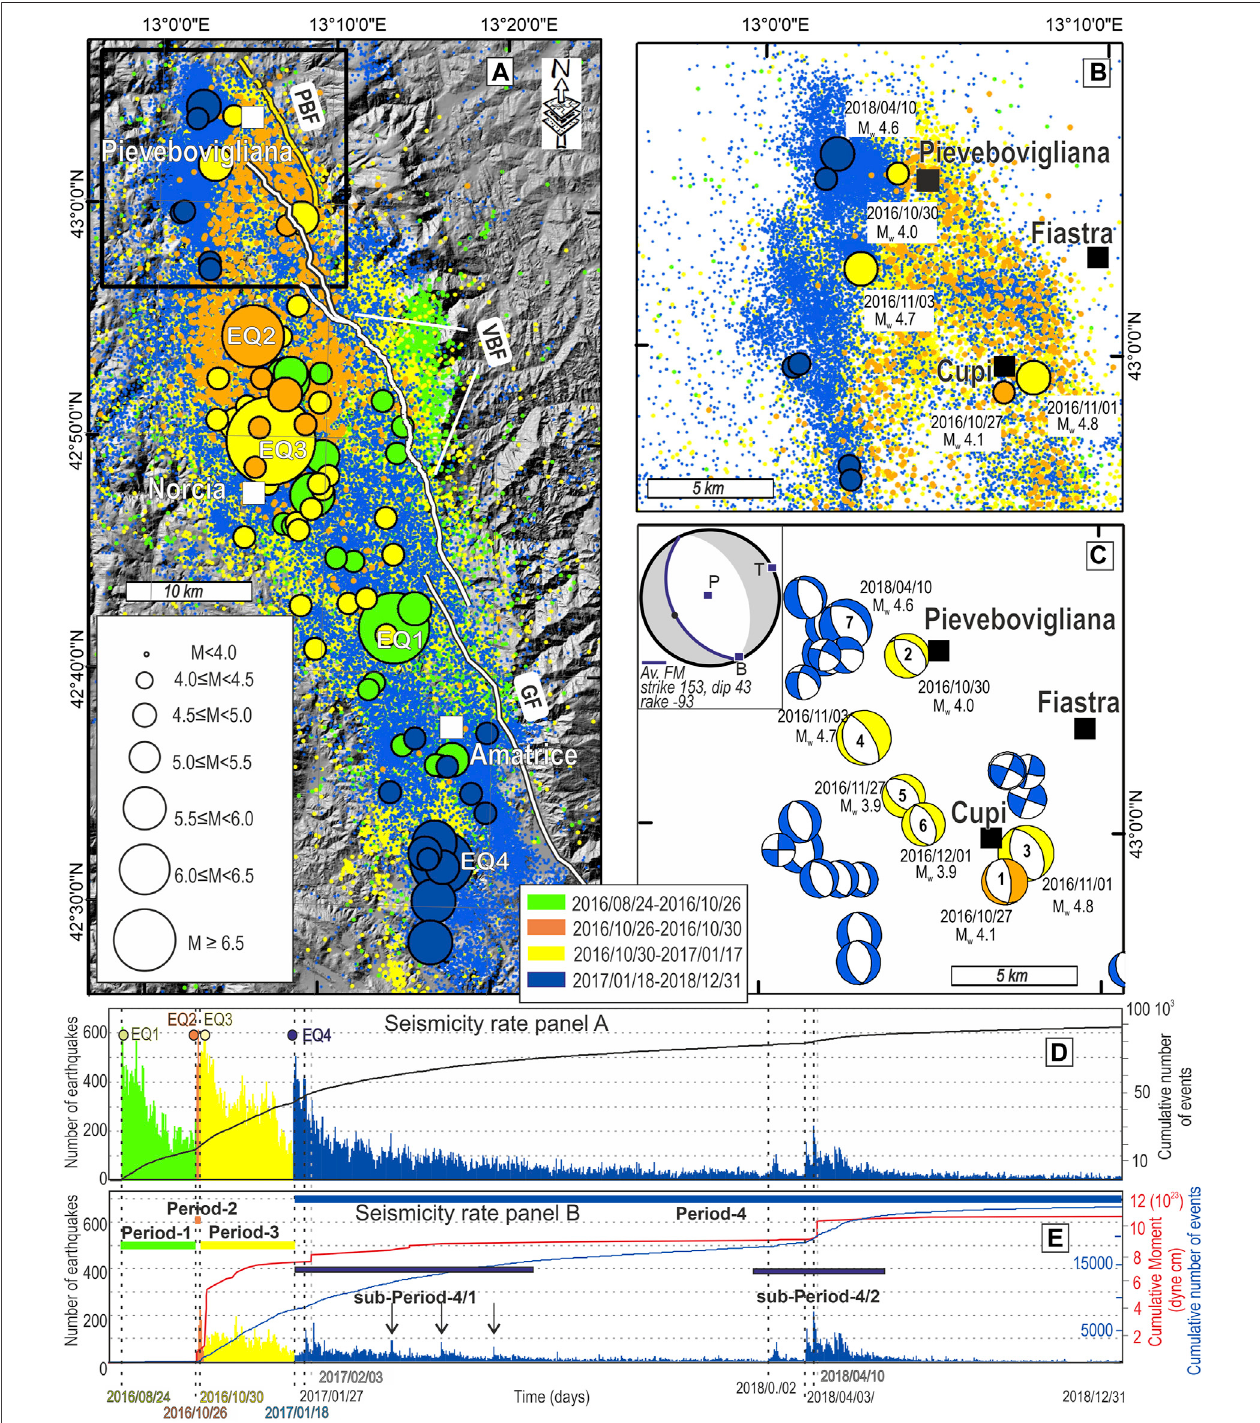
FIGURE 2 | Spatio-temporal evolution of seismicity from August 24, 2016 to December 31, 2018. (A) Epicentral distribution of earthquakes occurred during the Norcia seismic sequence with M L ≥ 1.0 and depth < 20 km reported by the Italian seismological Instrumental and Parametric database (ISIDe Working group, 2007). The colors of epicentres indicate four different time intervals following the main seismic events: August 24, 2016, M w (cid:1) 6.0 (EQ1; green); October 26, 2016, M w (cid:1) 5.9 (EQ2; orange);October30,2016,M w 6.5(EQ3;yellow);January18,2017,M w 5.5(EQ4;blue).Mreferstomomentmagnitudeforthelargereventsandlocalmagnitudefor smallearthquakesasreportedbythecitedcatalog (B) Focusontheseismicitydistributioninthestudyarea (C) Focalmechanismsofsigni fi cantearthquakesofthestudy area, divided into four sub-groups in accordance with the de fi ned time intervals. The focal solution labelspoint out the temporal occurrence ofthe most signi fi cant event